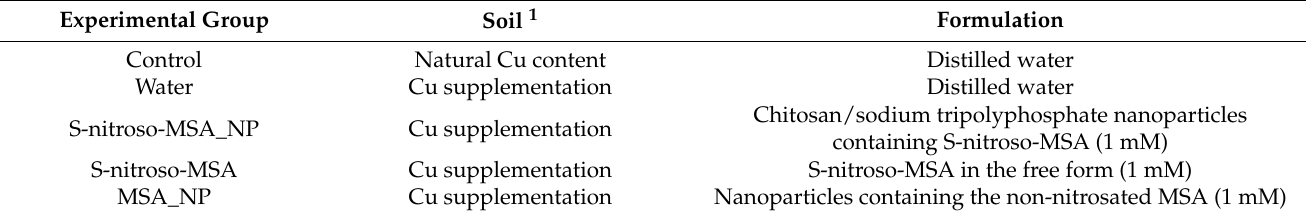
Table 2. Treatments applied to the soybean plants. Experimental Group Soil